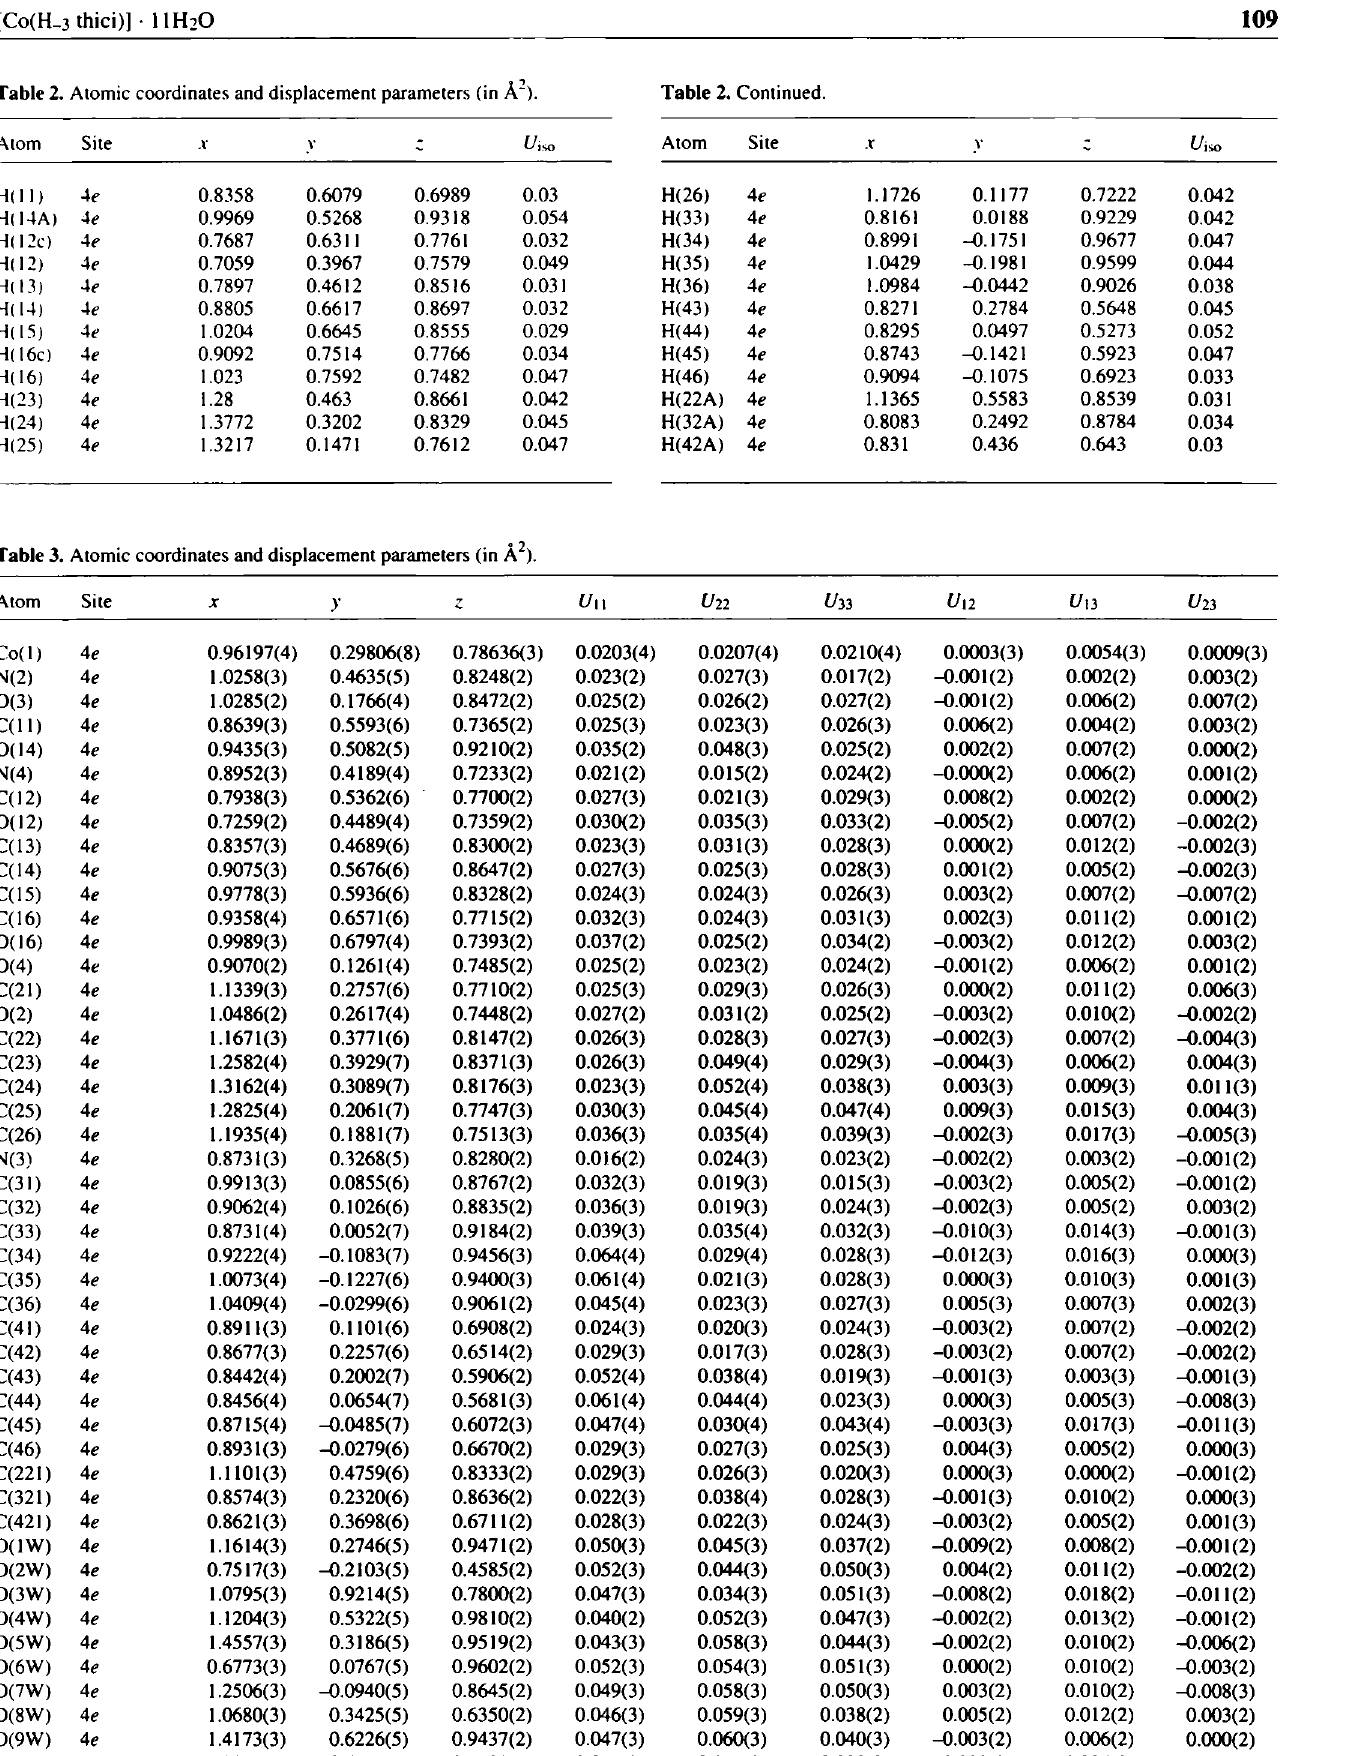
Table 2. Atomic coordinates and displacement parameters (in A 2 ).